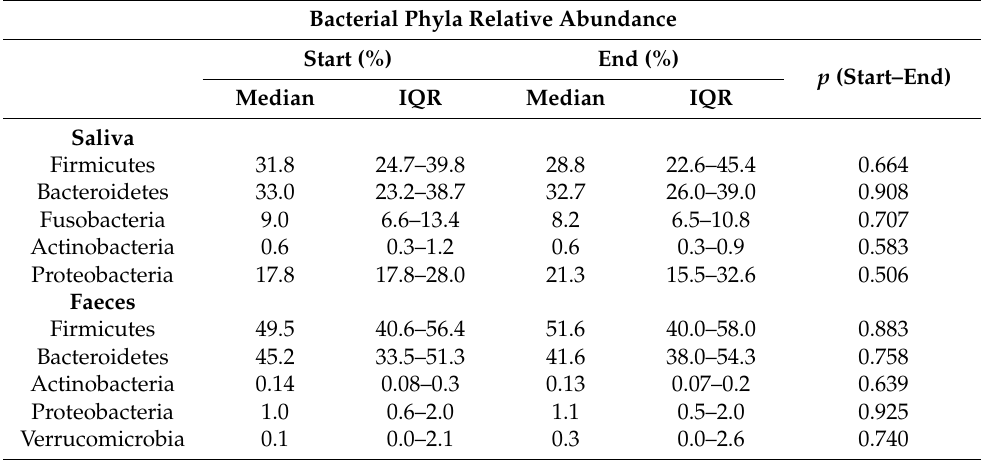
Table 4. Relative abundance of bacterial phyla in saliva and faecal samples expressed as median and interquartile range (MD ± IQR) at the start and end of the study.